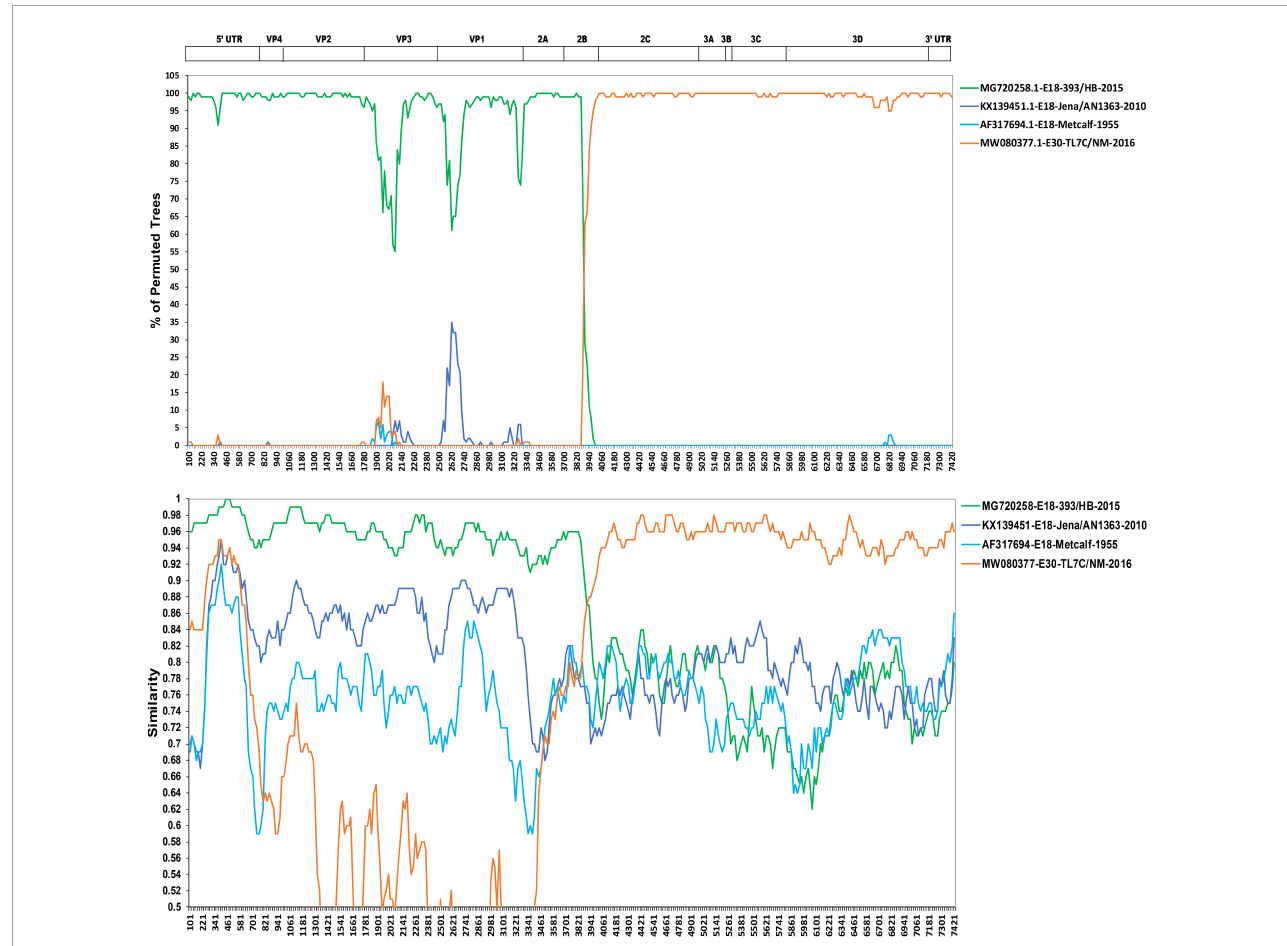
FIGURE4 Similarity plot and bootscanning analyses of the two echovirus 18 strains based on their full-length genomes. Four potential parental strains of echovirus 18 and echovirus 30 were subjected to similarity plots and bootscanning analyses using Simplot v3.1